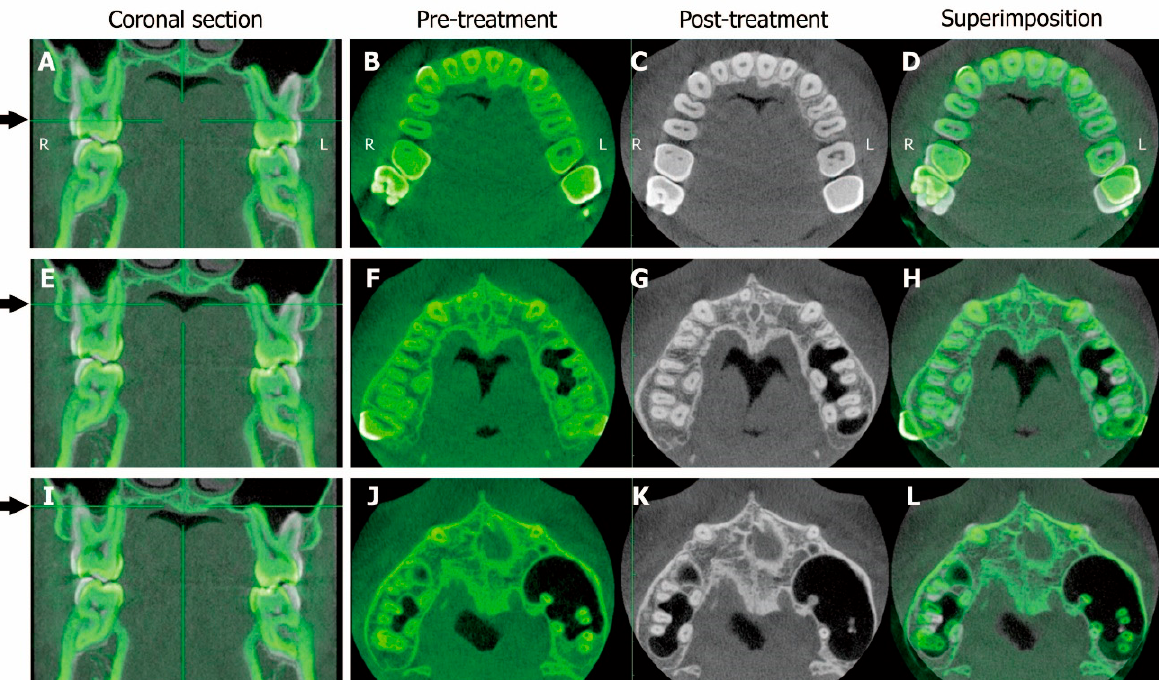
Figure 13. Three-dimensional cone-beam computed tomography (CBCT) images of the relationships between the maxillary molars and maxillary sinus. ( A – D ) CBCT coronal section at the crown level of the maxillary first molars ( arrow ), CBCT axial sections at post-treatment ( gray ) and pretreatment ( green ), and their superimposition; ( E – H ) CBCT coronal section at the root level of the maxillary first molars ( arrow ), CBCT axial sections at post-treatment ( gray ) and pretreatment ( green ), and their superimposition; ( I – L ) CBCT coronal section at the root apex level of the maxillary first molars ( arrow ), CBCT axial sections at post-treatment ( gray ) and pretreatment ( green ), and their superimposition.